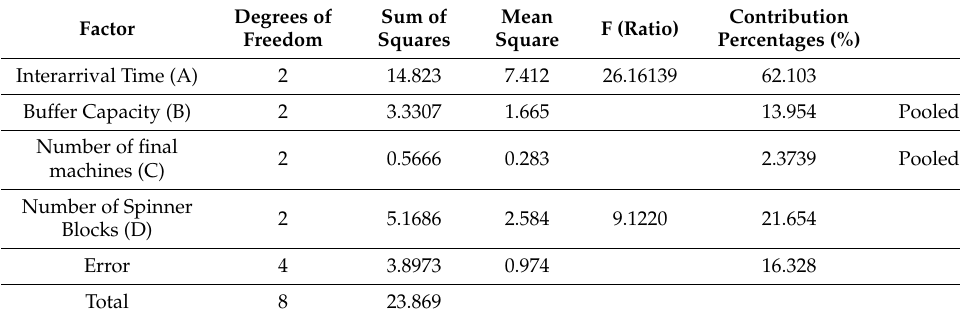
Table 11. ANOVA table with pooled factors for error variance estimation. Factor